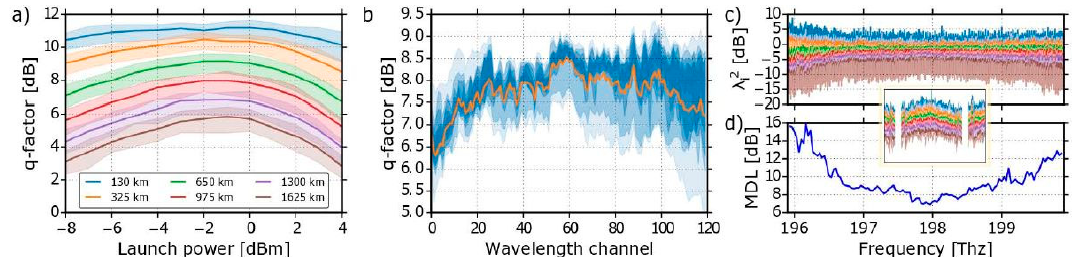
Figure 35. ( a ) Q-factors vs. power for 15 WDM channels; ( b ) Q-factors vs. WDM channels; ( c ) singular values after 650-km transmission; ( d ) average MDL vs. frequency per WDM channel [48].